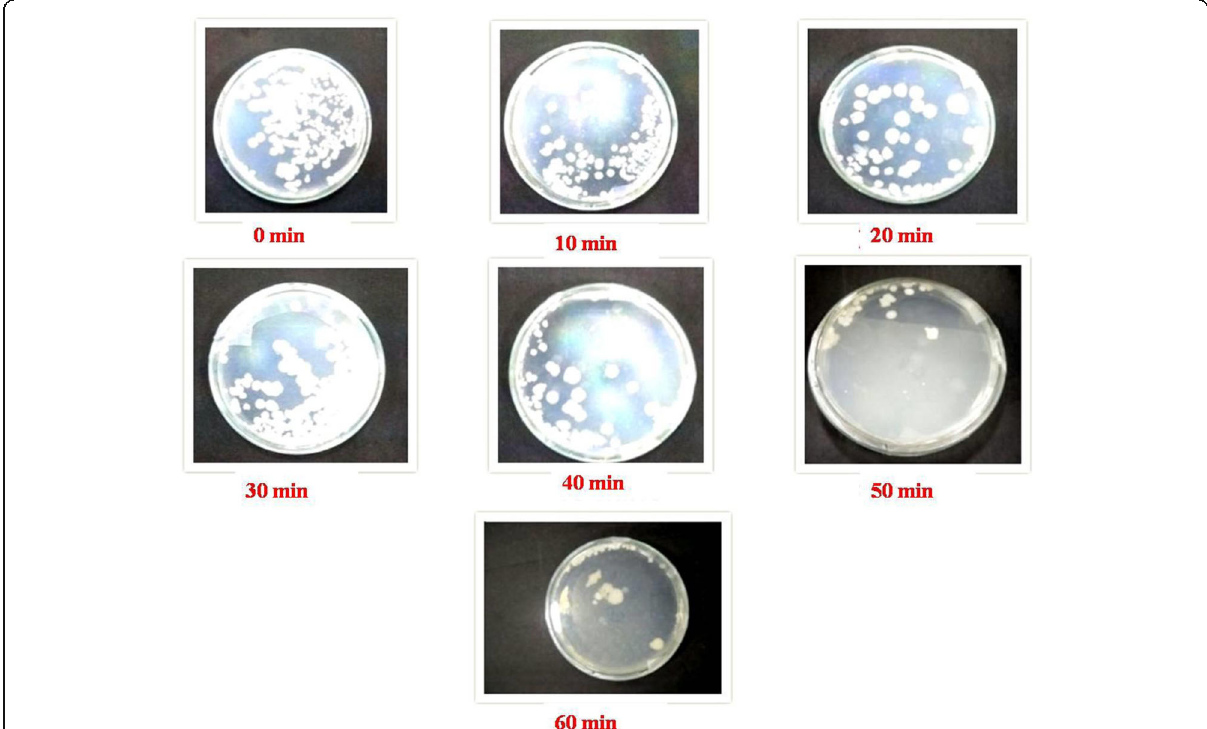
Fig. 10 Pathogenic growth inhibition when biosynthesised SeNPs are treated with lake